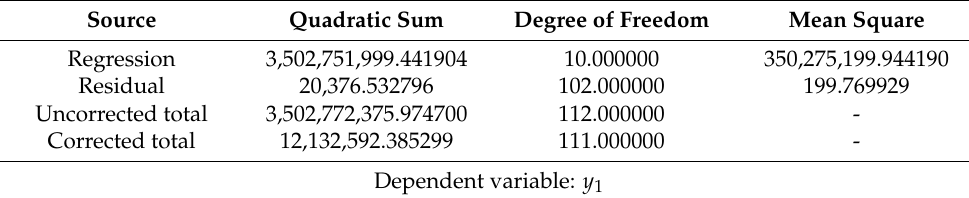
Table 8. Analysis of variance table. Source